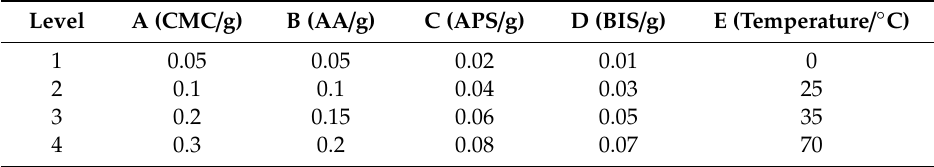
Table 2. Level factor of the orthogonal